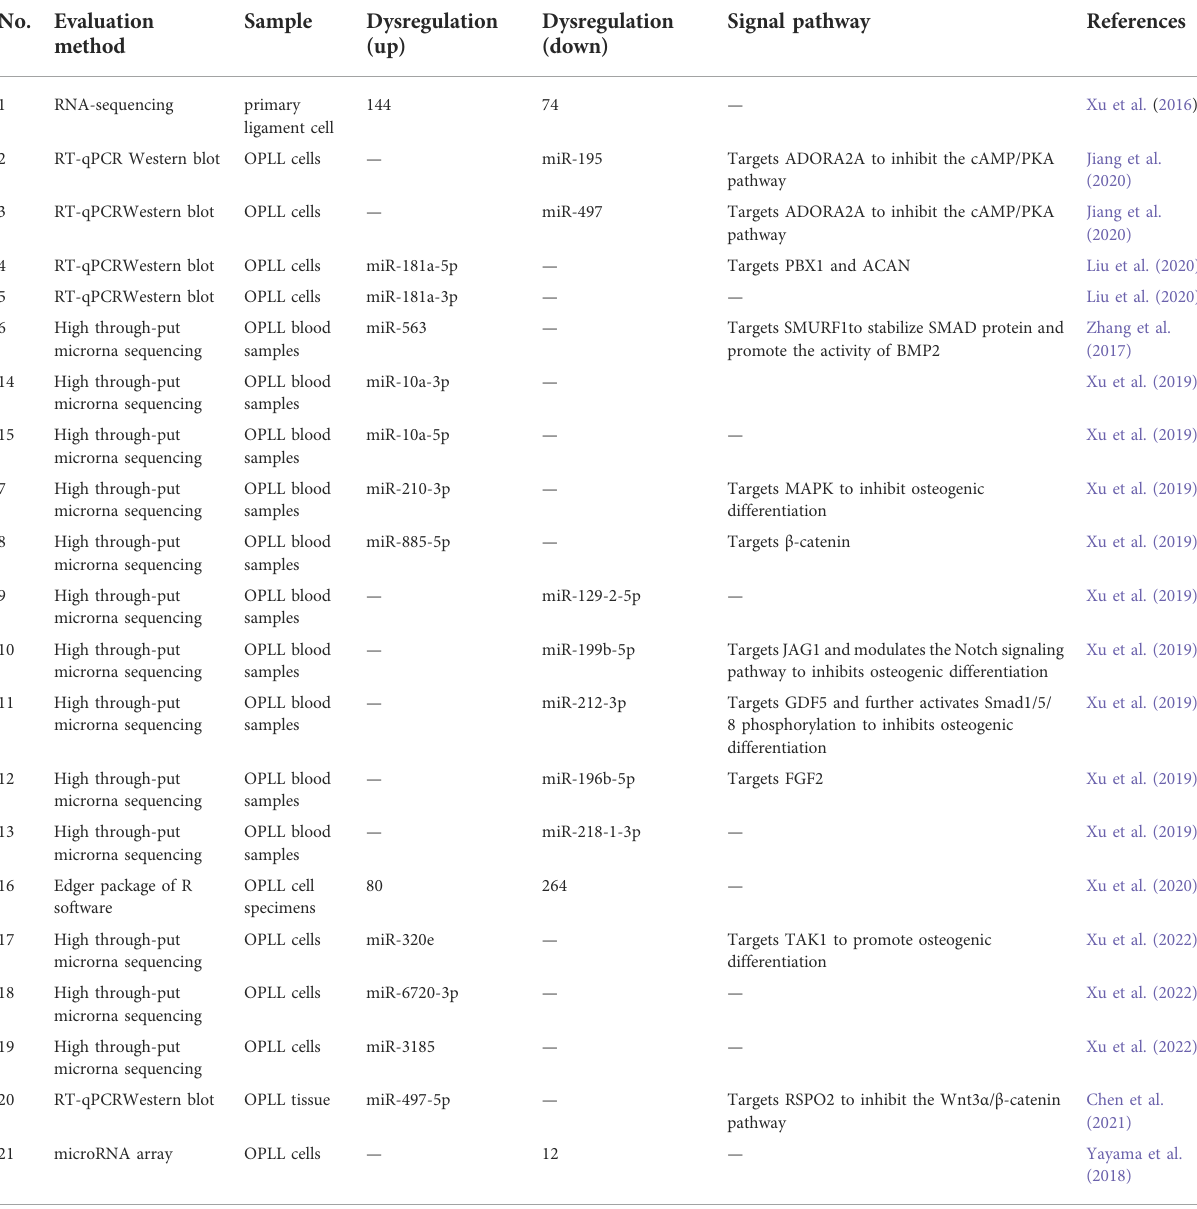
TABLE 2 MiRNAs expression pro fi les in